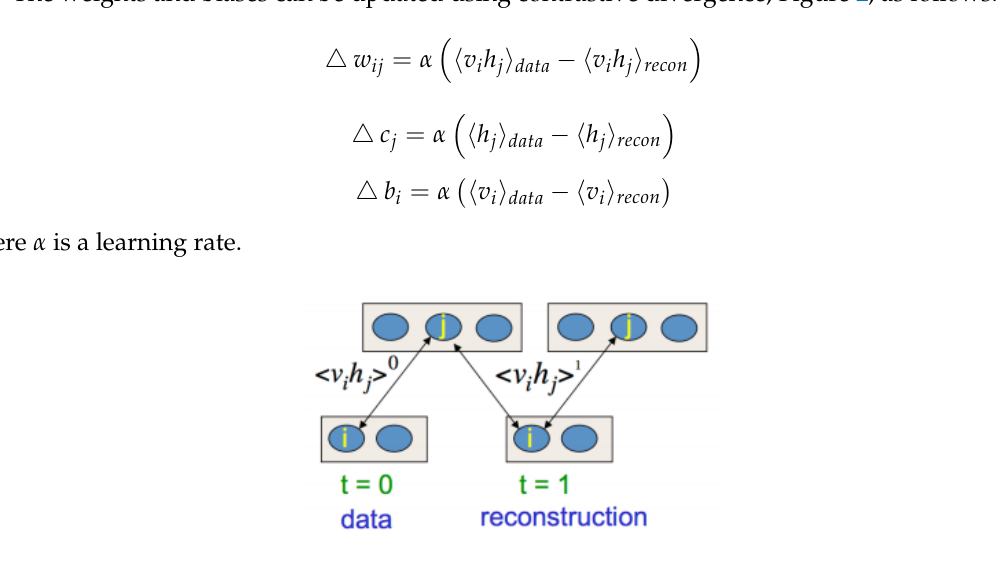
Figure 2. A single step of contrastive